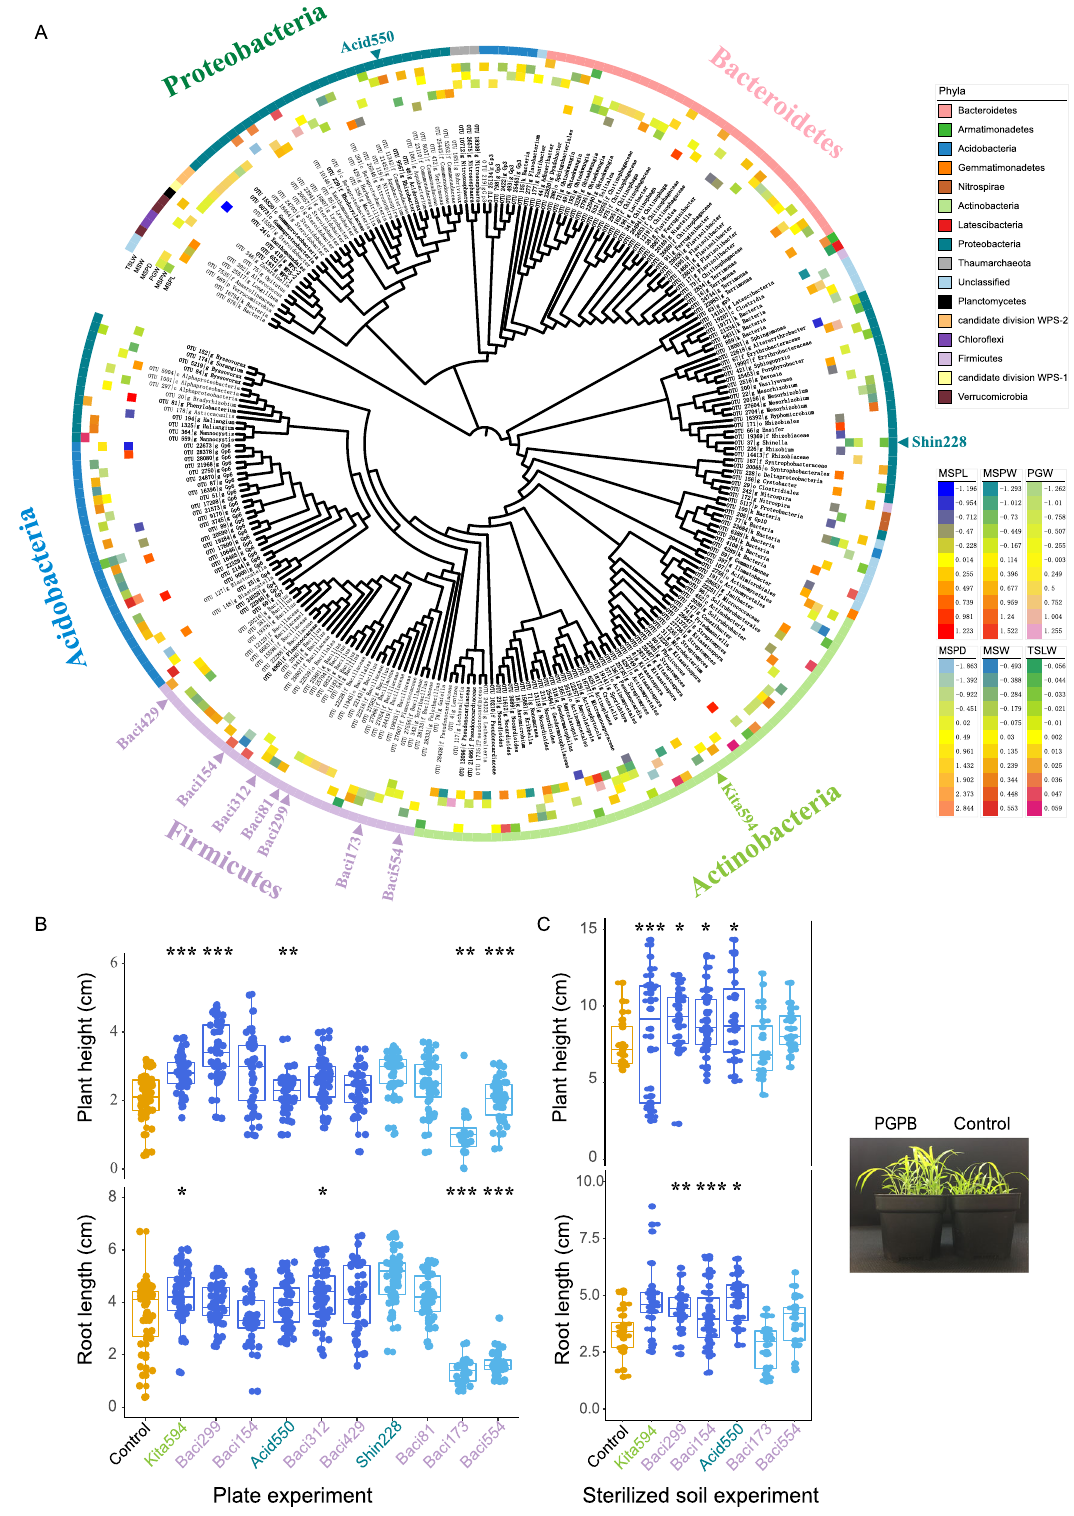
(Fig. 4C). Intriguingly, the expansin gene that mediates cell wall loosening and increased root and shoot growth in rice 41 , was induced by all of the growth-promoting